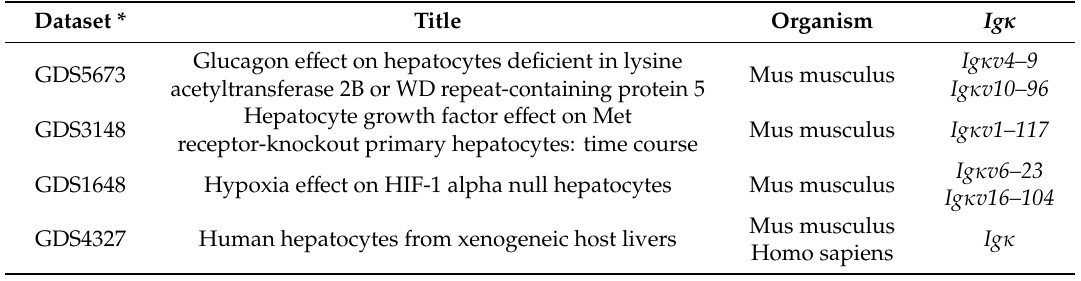
Table 1. Ig κ expression in human or mouse hepatocytes from Gene Expression Omnibus (GEO) Profiles.